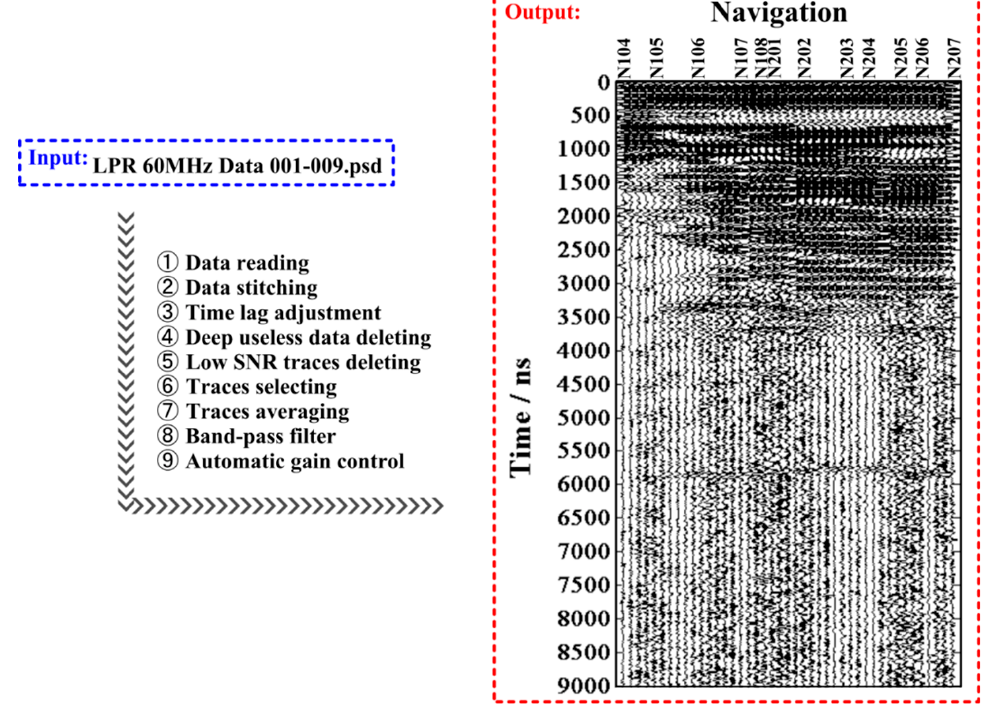
Figure 3. The flowchart of the CH-1 (lunar penetrating radar) LPR data preprocessing (left). The output is the LPR CH-1 data after preprocessing (right). N104–N207 denote the positions where the LPR was rebooted.